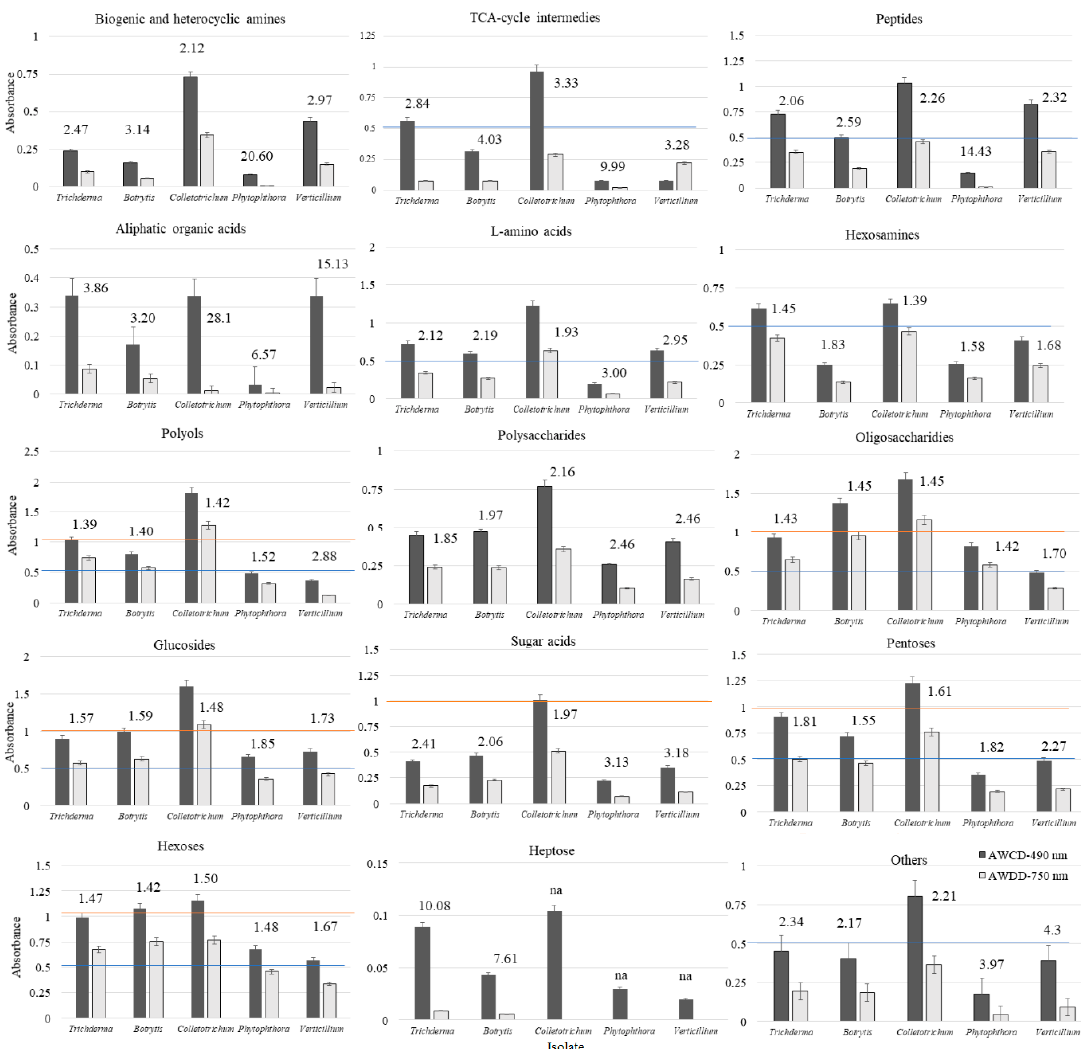
Figure 3. AWCD and AWDD ratio values of substrate groups calculated on the basis of consumption (Average Well Colour Development—AWCD, 490 nm) and growth (Average Well Density Development—AWDD) potentiates (A > 0.2, n = 3); “na” – indicates not available.